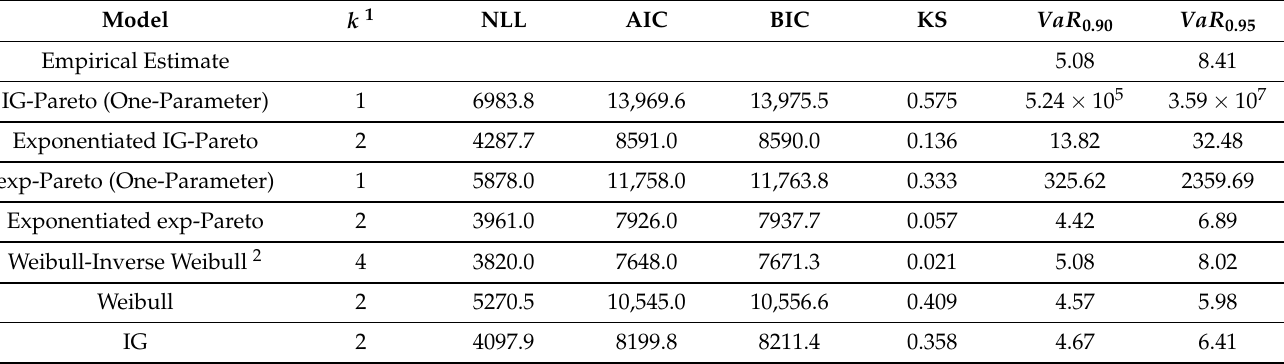
Table 3. Comparisons of different models, with the Danish fire insurance